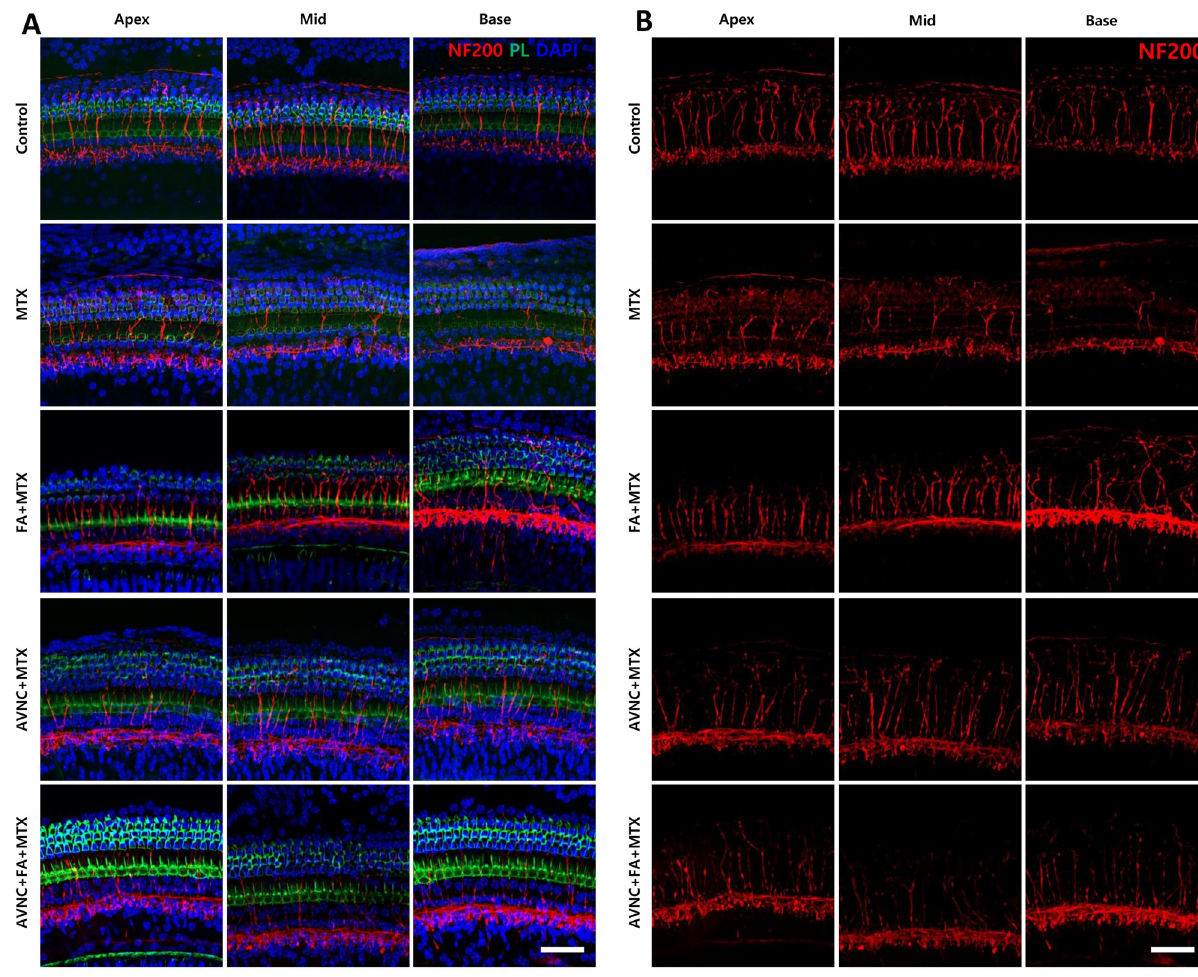
Fig 5. AVN-C safeguards the cochlear neuron integrity from the detrimental effects of MTX. Cochlear neurodegeneration was examined along cochlea turns with anti-neurofilament 200 (NF200) (Fig 5B). Under a confocal microscope, severe degeneration of cochlear neurons was observed, which was more pronounced at the basal turn than in the middle and apex portions in the MTX-treated group (Fig 5B). In the FA+MTX-treated group, the cochlear neurons at the basal turn showed discontinuity and deformity but preserved in the middle and apex turns of the cochlea. On the contrary, treatment with an antioxidant AVN-C alone as well as the combination of AVN-C and FA gave a well-defined cochlea neuronal integrity, while treatment with MTX disrupted cochlea neurons throughout the cochlear turns (Fig 5A and 5B). The following antibodies were used in staining: anti- neurofilament 200 (NF200), phalloidin (PL), and DAPI; the merged image shows the OHCs (Fig 5A): The scale bar used is 50 μ